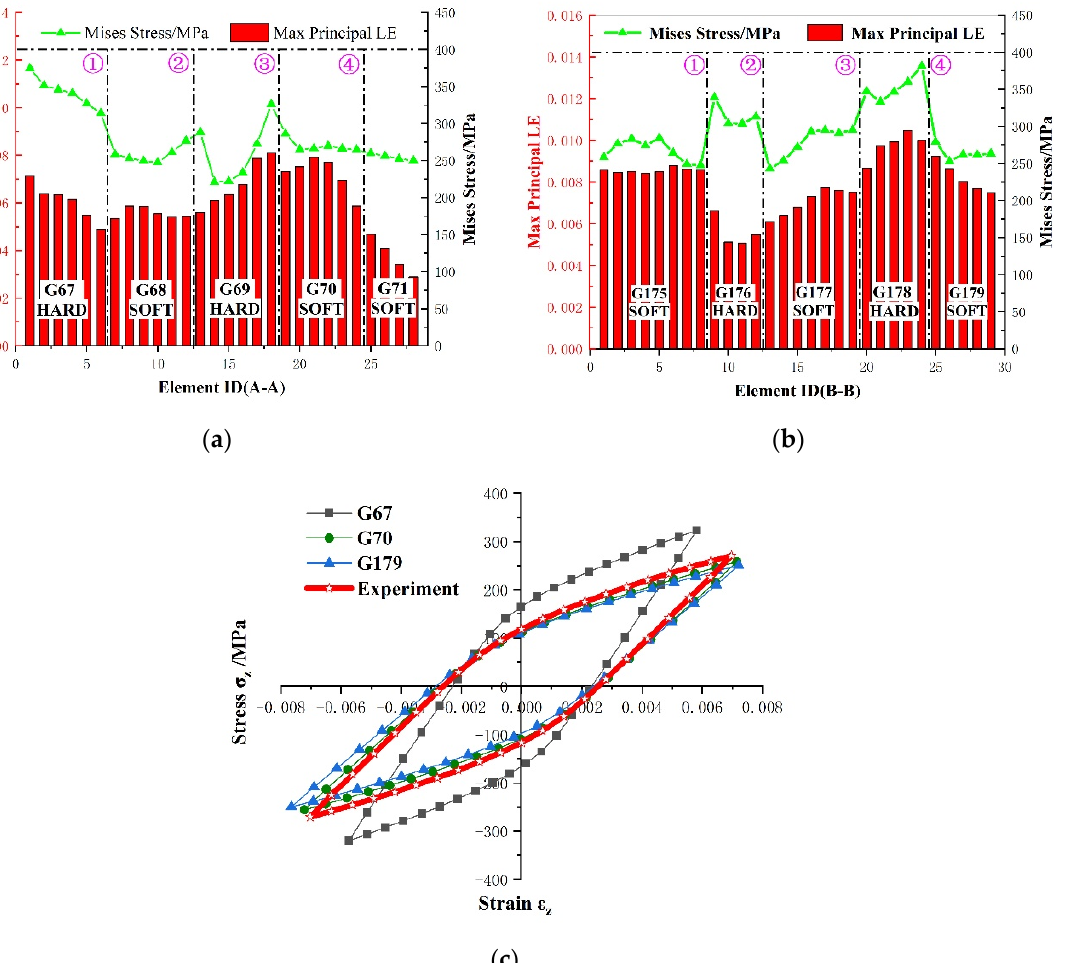
Figure 12. Local stress and strain analysis arising from the preferred crystallographic orientation and neighbor grain constraint effect: along the ( a ) horizontal line A; ( b ) horizontal line B; ( c ) cyclic response for specified grains.